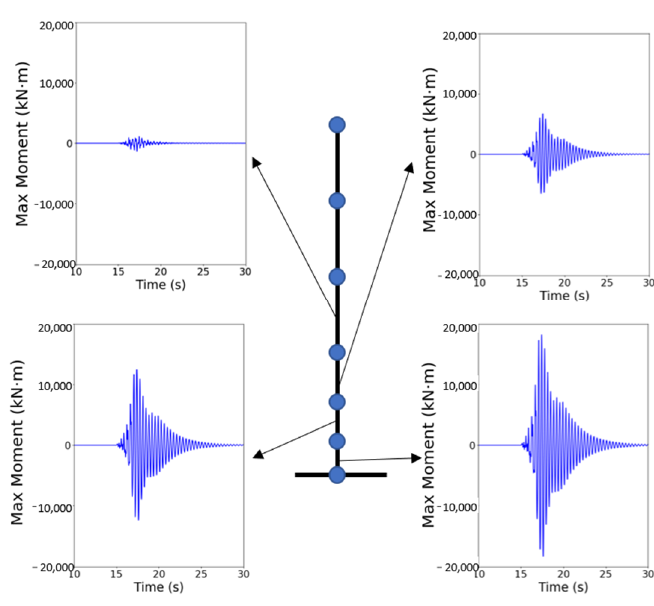
Figure 10. Variation in the moment along the length of a pier.